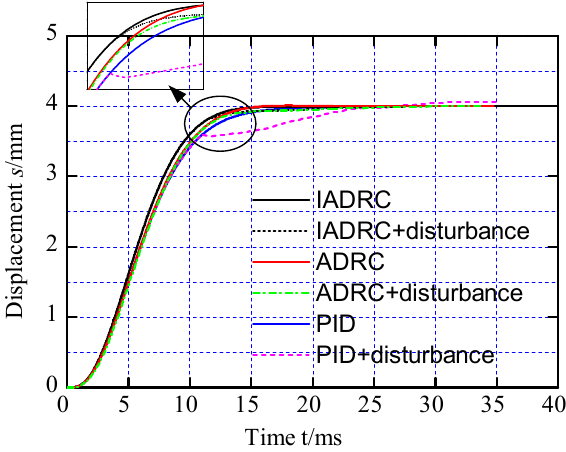
Figure 13. Comparison of disturbance rejection performance.